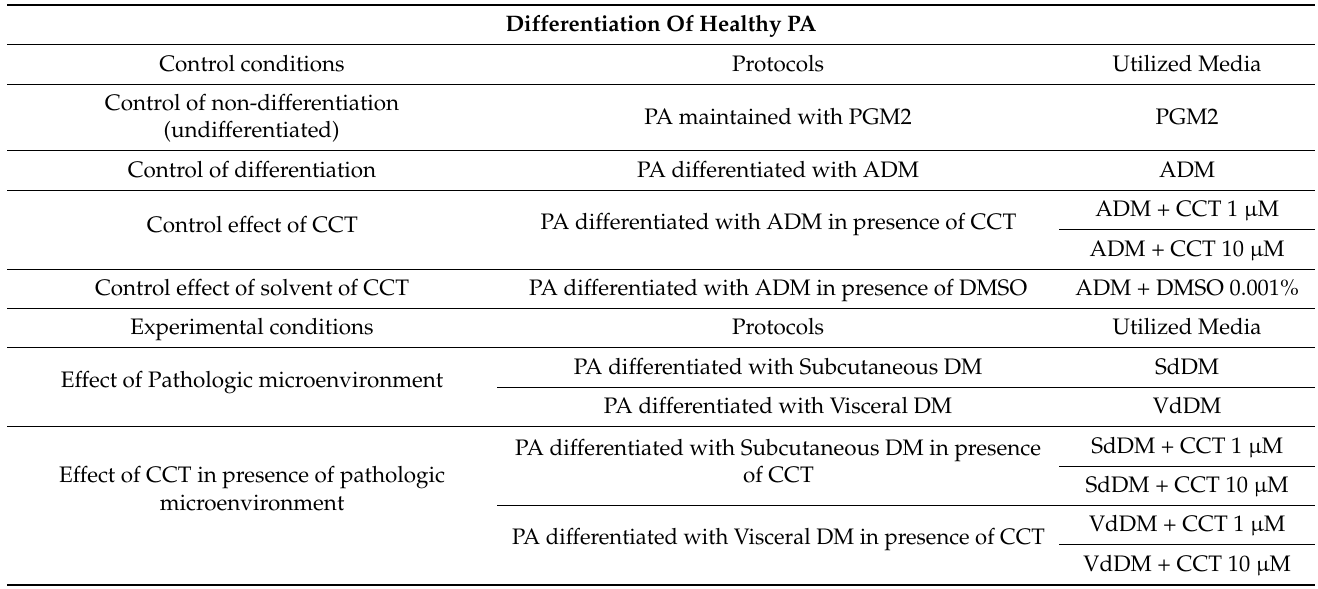
Table 1. Conditions established and media used on the differentiation of healthy preadipocytes (PA). Differentiation Of Healthy